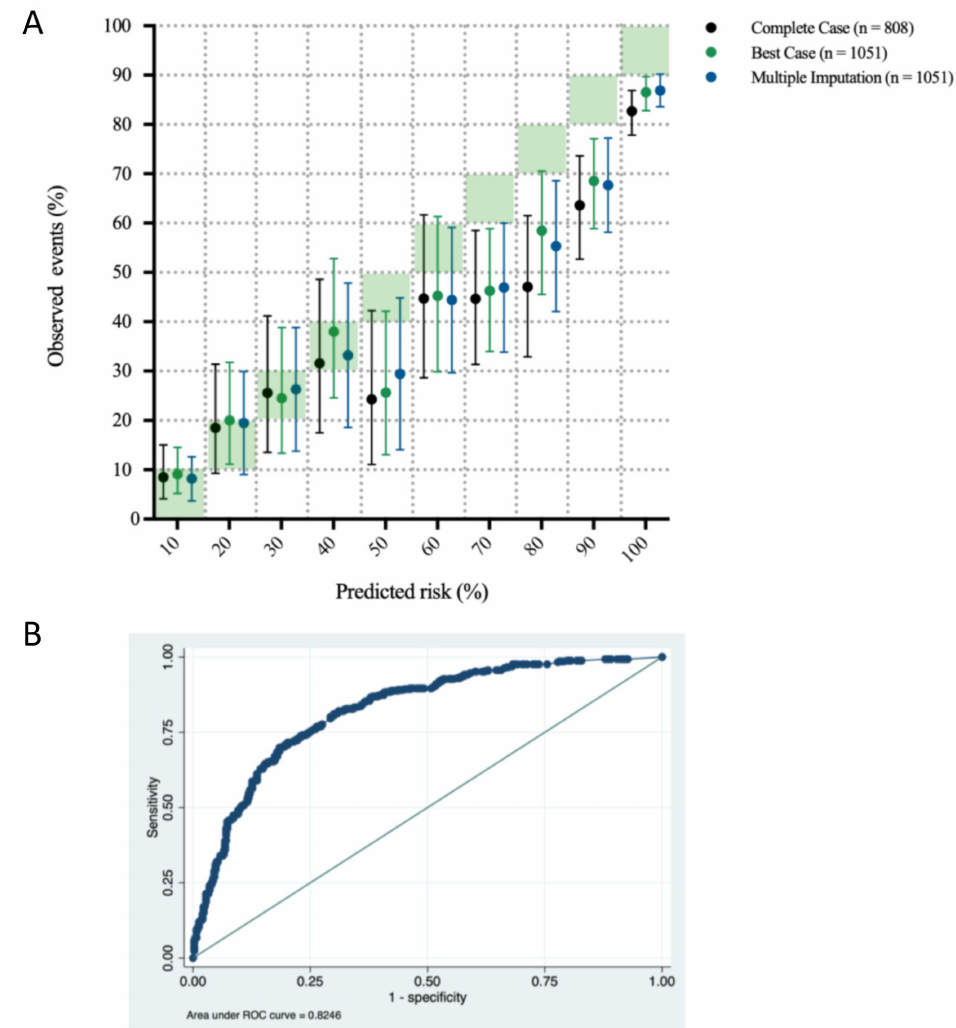
Figure 1. ( A ) Observed event point estimates with 95% CIs by predicted risk deciles of poor neurologic outcomes. X-axis: Risk deciles as predicted by the PROLOGUE score; Y-axis: Observed event estimates with 95% CI (bars) for the complete case analysis (Hosmer–Lemeshow test p = 0.0024), and after best case (Hosmer–Lemeshow test p = 0.0058) and multiple data imputation (Hosmer–Lemeshow test p = 0.0122). ( B ) ROC curve for the PROLOGUE score applied to the complete case dataset. X-axis: 1-specificity; Y-axis: Sensitivity. Abbreviation: ROC curve, Receiver Operating Characteristic